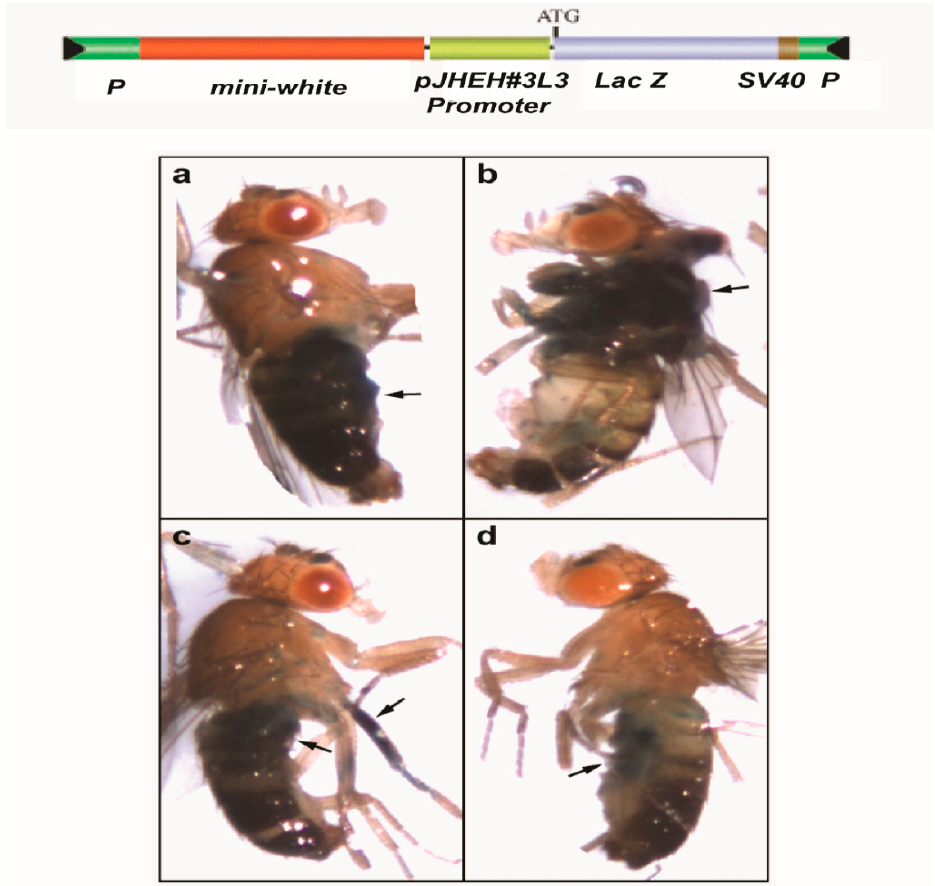
Figure 12. D. melanogaster flies that were transformed with jheh 3 promoter pJHEH#3L3 (colored green) in pCaSpeR-AUG- β gal behind lac Z (colored magenta) upper bar. Arrows point to β -galactosidase activity in the abdomen ( a ), in the thorax ( b ), in the leg muscle and upper abdomen next to the thorax ( c ) and the ventral part of the abdomen ( d ).